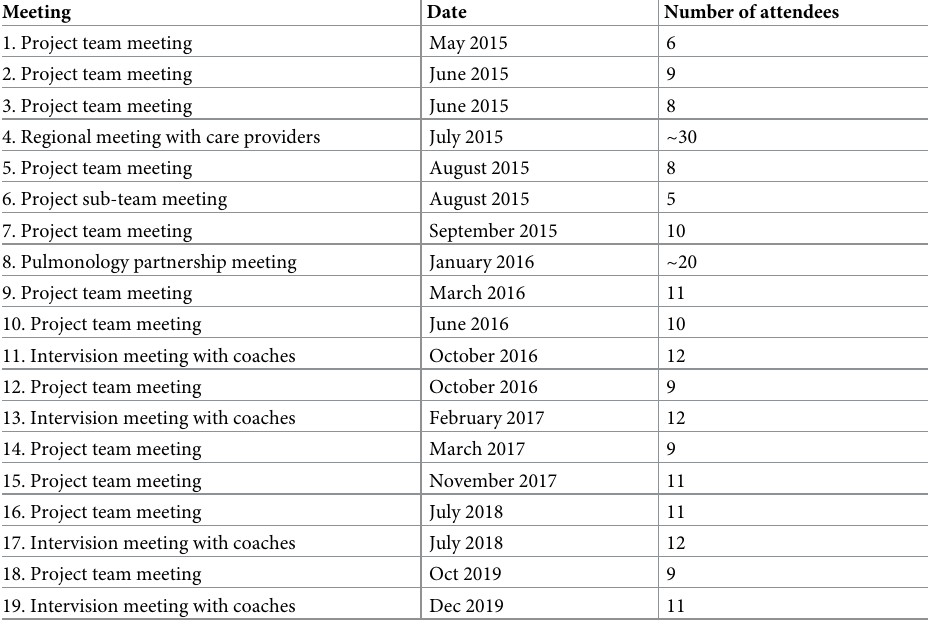
Table 1. Project team meetings and related meetings.